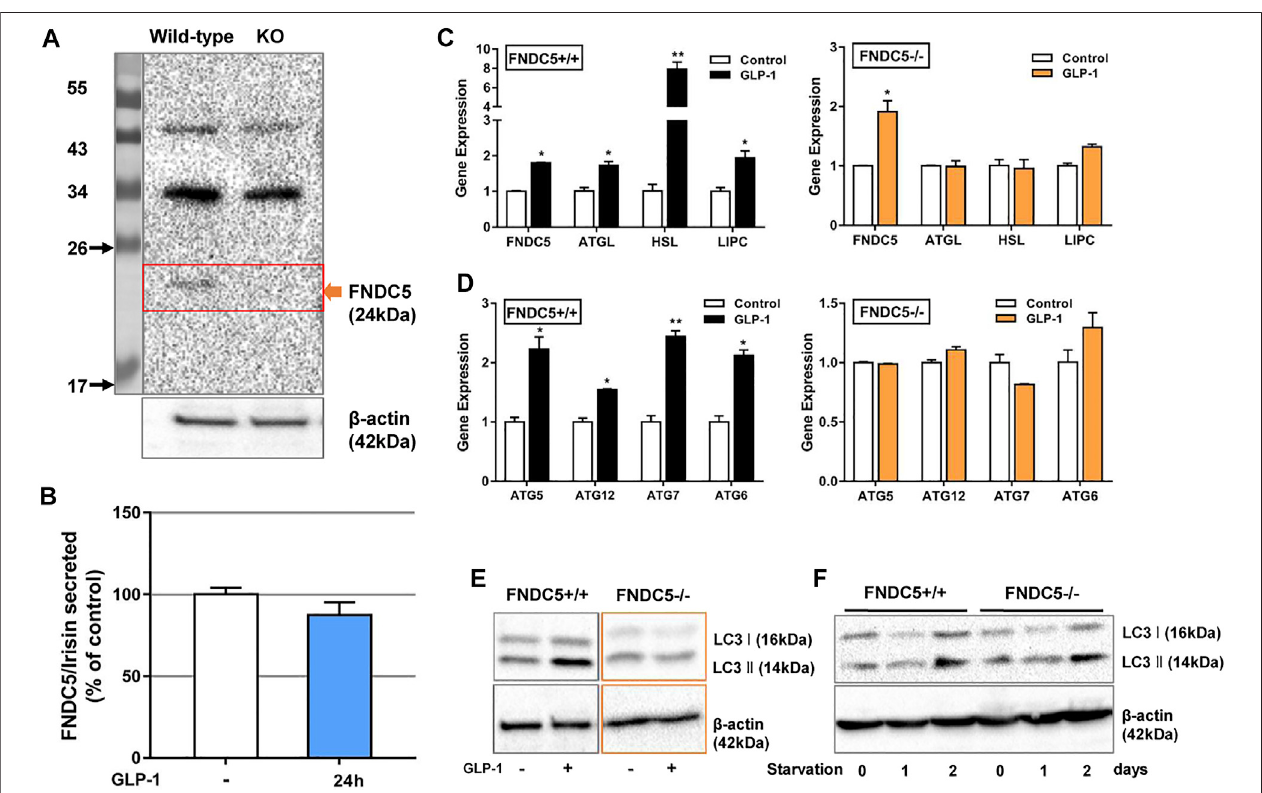
FIGURE 4| FNDC5 mediates the GLP-1 induced lipolysisgenesexpression and autophagy of β cells. (A) FNDC5 protein wasnot expressed in its KO β Lox5 cells. β -Actin expression was used as a control in western blotting analysis. (B) GLP-1 (100 nM) failed to increase the secretion of FNDC5/irisin in FNDC5 KO β Lox5 cells ( n (cid:1) 3). GLP-1 failed to activate the expression of lipolysis genes (C) and autophagy-related genes (D) . Wild type or FNDC5 KO β Lox5 cells were treated with GLP-1 (100 nM) for 16 h before RT-qPCR analysis ( n (cid:1) 3). (E) The expression of LC3 I/II was not enhanced by GLP-1 in FNDC5 KO β Lox5 cells. Wild type or FNDC5 KO β Lox5 cells were treated with GLP-1 (100 nM) for 24 h before western blotting analysis ( n (cid:1) 3). (F) β Lox5 cells were cultured in FBS free medium for indicated time and anti-LC3I/IIantibodieswereusedtoprobecelllysatesfollowingSDS-PAGE. β -Actinexpressionwasusedasacontrol.Valuesaremean ± SEM.* p < 0.05and** p < 0.01.